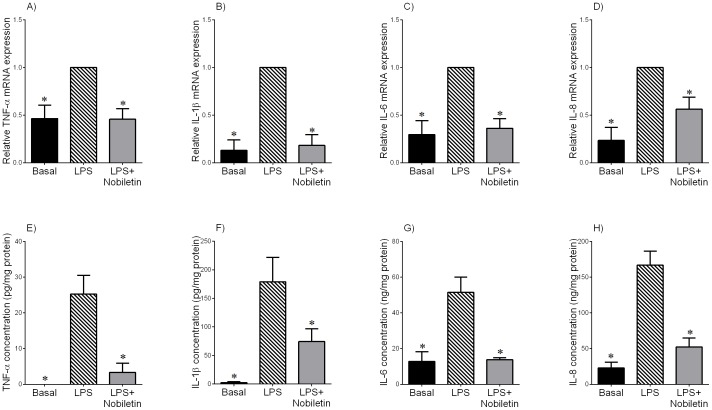
Effect of nobiletin on LPS-induced cytokine expression and release in term myometrium.Human myometrium was incubated with or without 10 µg/mL of LPS in the absence or presence 200 µM of nobiletin for 20 h (n = 6 patients per group). (A–D) TNF-α, IL-1β, IL-6 and IL-8 mRNA expression was analysed by qRT-PCR and normalised to GAPDH mRNA expression. The relative fold change was calculated relative to LPS and data presented as mean ± SEM. *P<0.05 vs. LPS (one-way ANOVA). (E–H) The incubation medium was assayed for concentration of TNF-α, IL-1β, IL-6 and IL-8 by enzyme immunoassay. Each bar represents mean concentration ± SEM. *P<0.05 vs. LPS (one-way ANOVA).